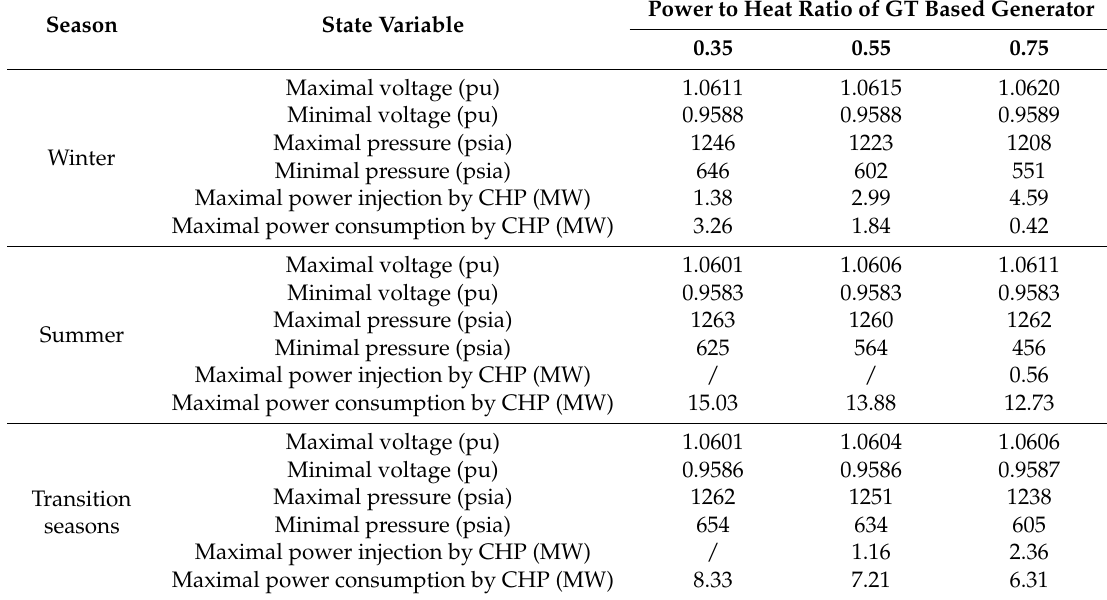
Table 3. System states under different power to heat ratio based CHP generations (FTL